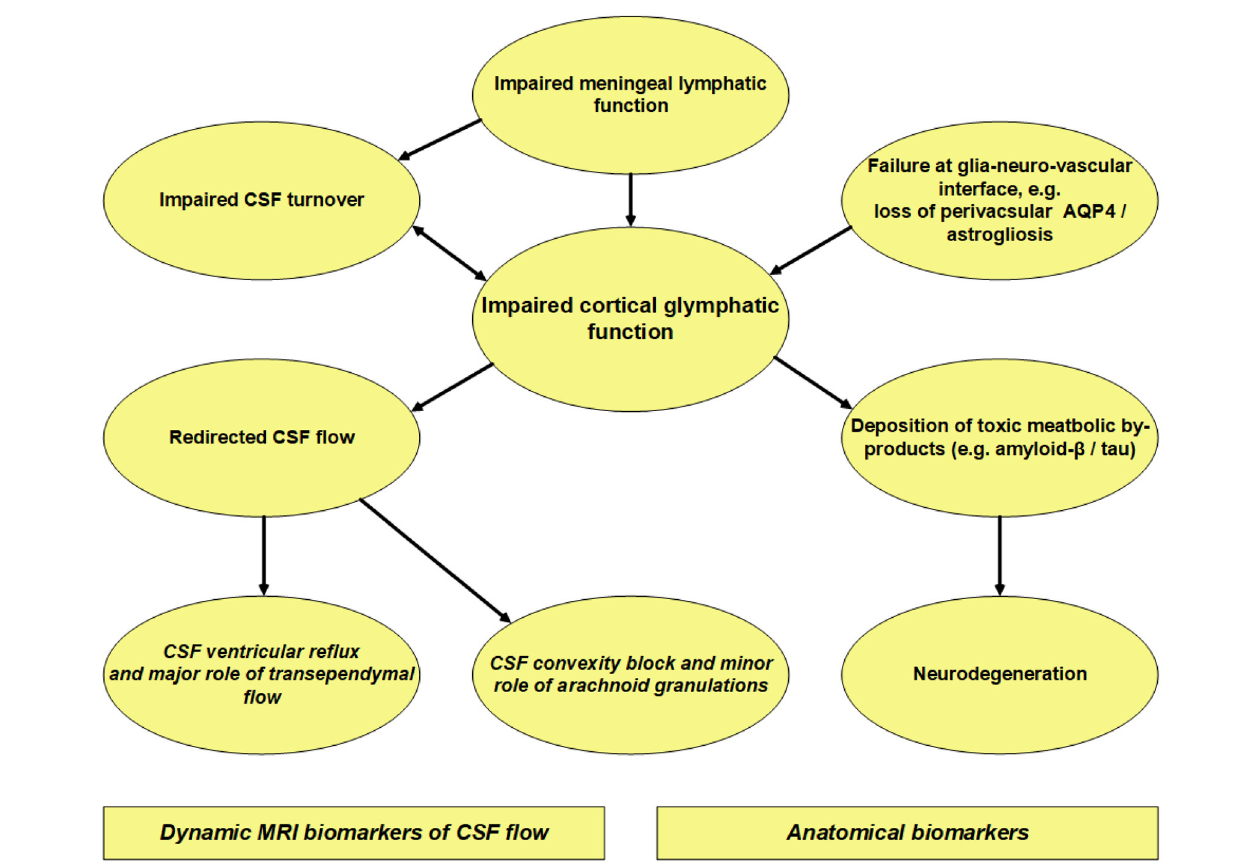
FIGURE 10 | Overview of our current thinking about iNPH pathophysiology based on MRI and histopathological observations in iNPH patients. Concerning intrathecal contrast-enhanced MRI, the contrast agent serves as a tracer within the extra-vascular compartment. This MRI modality showed delayed clearance of tracer from the cerebral cortex (24, 26, 27), which may indicate impaired glymphatic function. Moreover, iNPH demonstrated delayed clearance of tracer from CSF (24, 26) indicative of impaired CSF turnover. Enrichment of tracer in the cerebral cortex was strongly correlated with enrichment in nearby subarachnoid CSF space (24, 26), suggesting that glymphatic clearance heavily depends on molecular clearance from CSF. Histopathological studies in iNPH at cortex show astrogliosis, loss of perivascular AQP4, blood-brain barrier dysfunction, and mitochondrial abnormality (77–81), all of which may affect perivascular solute transport and thereby impair glymphatic function. A typical finding in iNPH is limited and protracted tracer enrichment at cerebral convexity with a peak at 24h (24), much later than peak concentration in blood (59). This indicates that clearance of tracer from arachnoid granulations to the superior sagittal sinus plays a minor role, though this has traditionally been considered the major efflux route ( 60). On the other hand, iNPH is characterized by marked tracer reflux to ventricles (grades 3–4) (17, 18), indicative of redistribution of CSF flow to ventricles. Possibly, reversed aqueductal flow with trans-ependymal transport of CSF and further resorption of water through capillary walls may be important in iNPH. We suggest that the meningeal lymphatic vessels serve as the major efflux route for larger molecules within the CSF compartments. Impaired clearance of toxic by-products of brain metabolism due to glymphatic and meningeal lymphatic clearance failure may underlie the deposition of amyloid- β and tau in iNPH (19), and signs of neurodegeneration shown as entorhinal cortex thinning and higher grades of Schelten’s MTA and Fazekas scores (18,